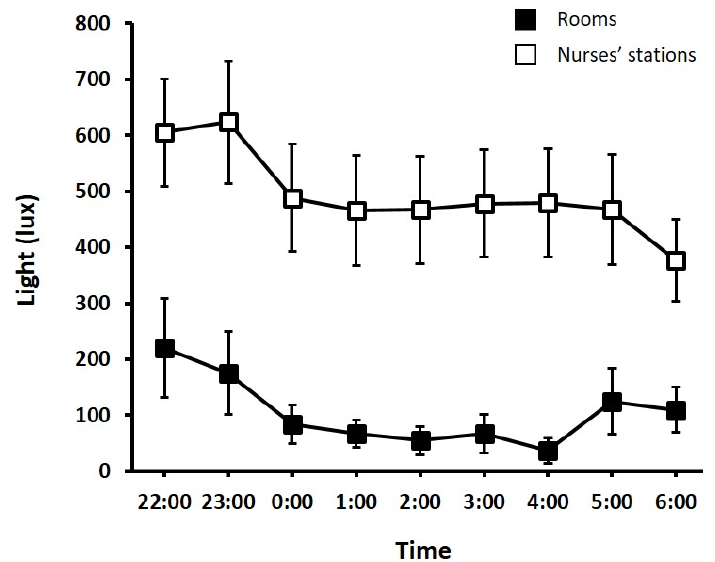
Figure 3. Light levels (lux) in rooms (closed squares) and nurses’ stations (open squares) overnight. Error bars are SEM. Error bars are